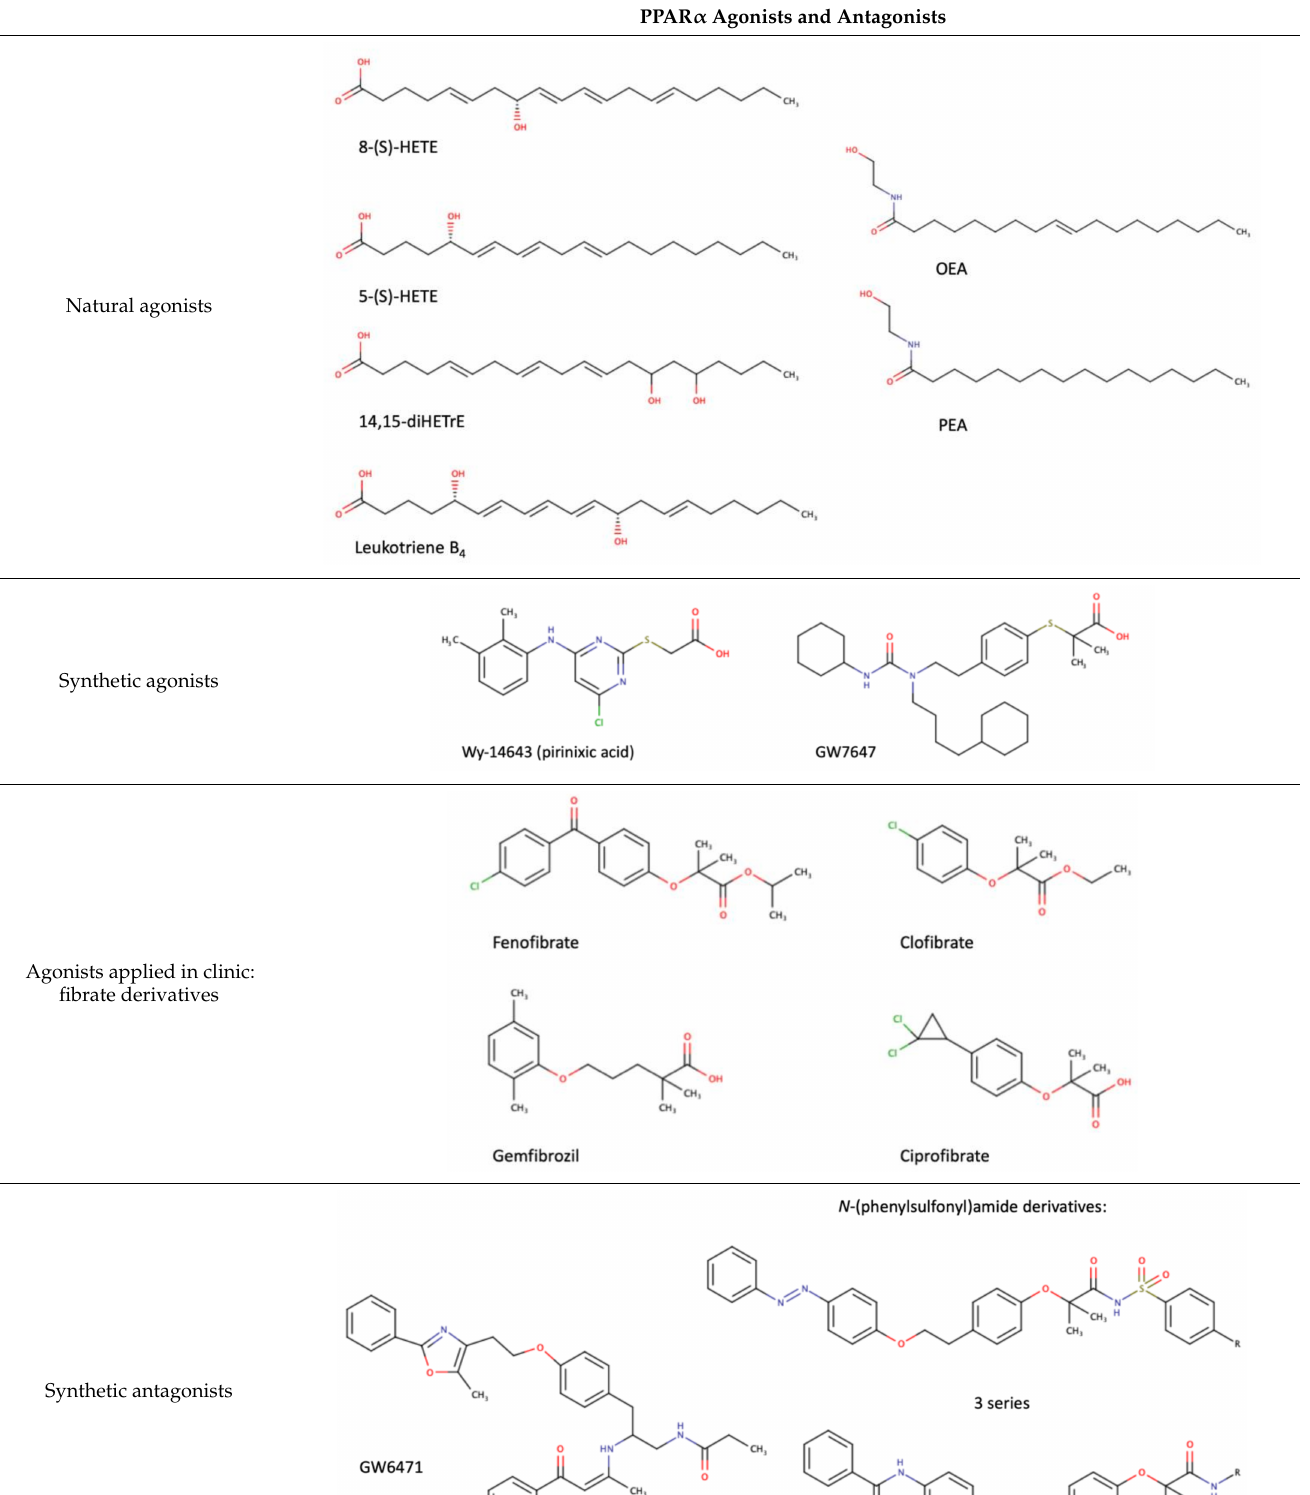
Table 1. Chemical structures of PPAR α endogenous agonists, synthetic agonists used in experimental studies, clinically used pharmacological agonists, and synthetic antagonists, including examples of novel N -phenylsulfonylamide compounds (the structures of 3- and 10- series according to